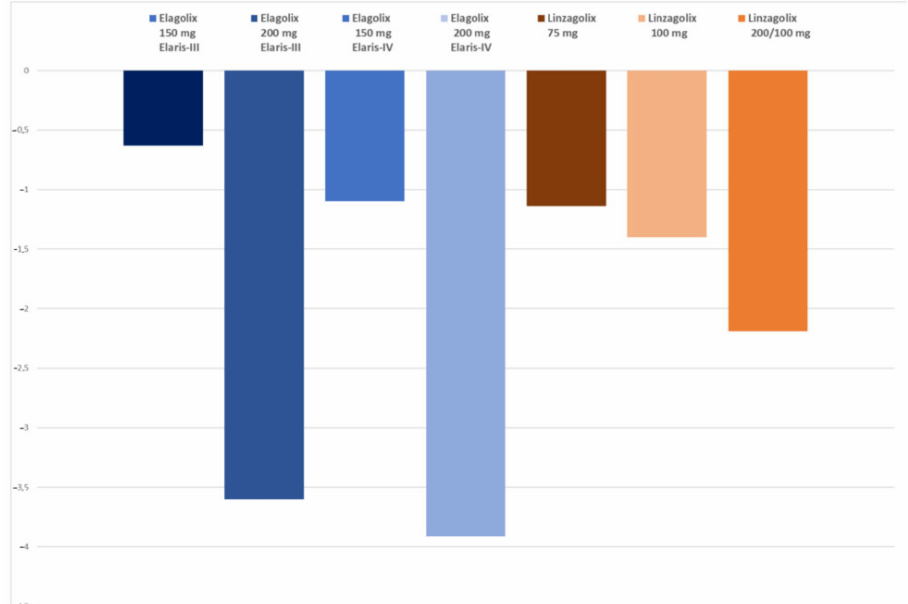
Figure 4. Mean percentage of BMD loss at week 52 (lumbar spine) in the different group of women treated by different doses of GnRH antagonist (elagolix and linzagolix). Patients randomized to linzagolix 200 mg were switched to linzagolix 100 mg at week